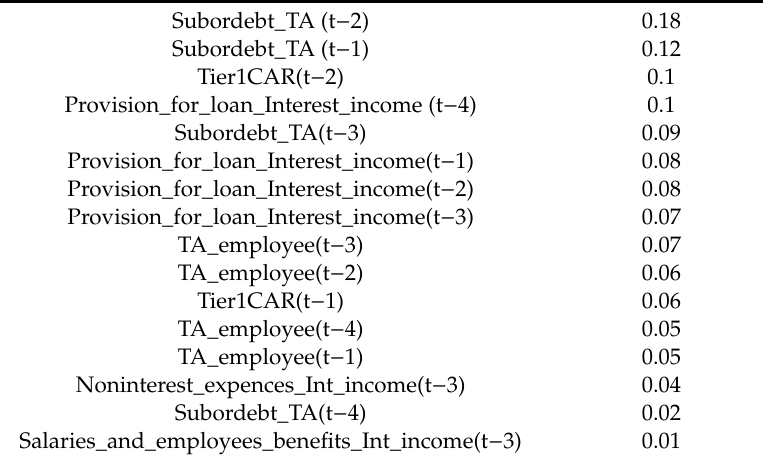
Table 2. List of features with positive weights assigned by the relief